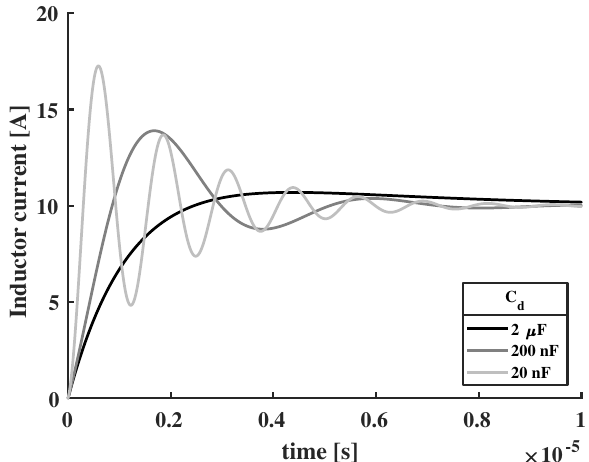
Figure 16. Simulation results for the inductor current in the circuit of Figure 15 for different damper